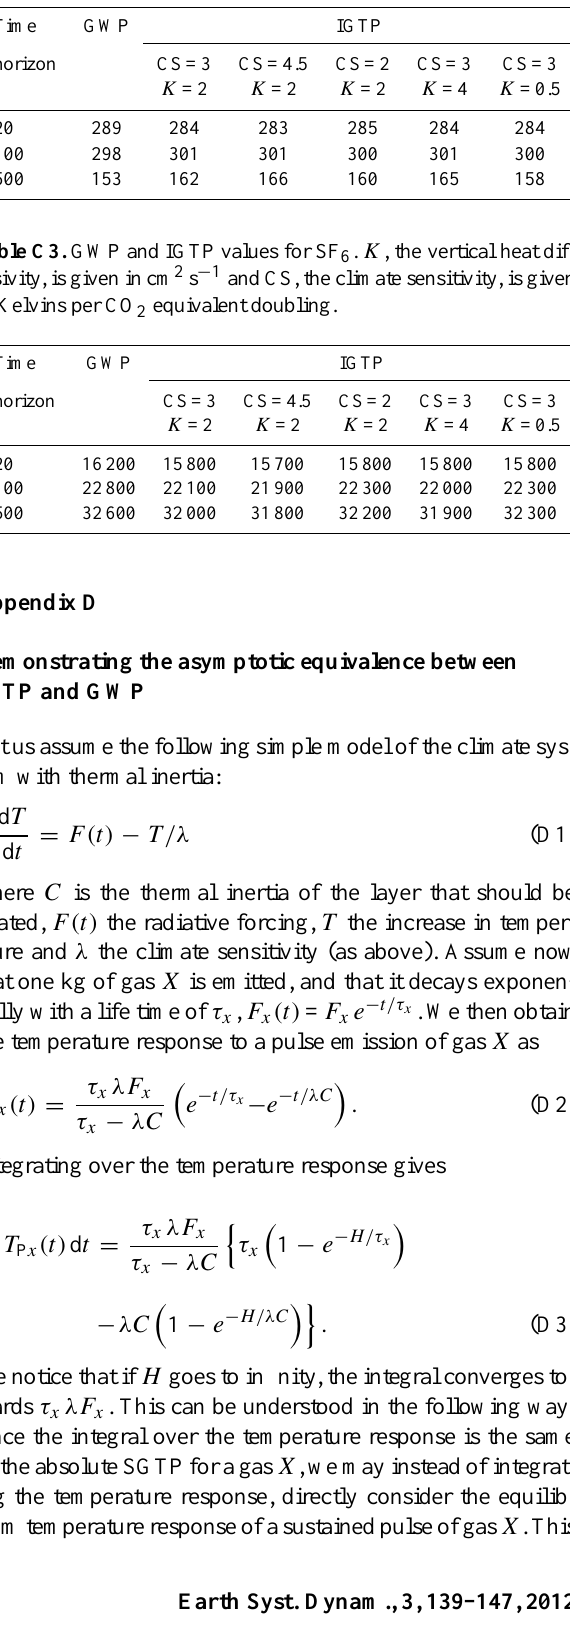
Table C2. GWP and IGTP values for N 2 O. K , the vertical heat diffusivity, is given in cm 2 s − 1 and CS, the climate sensitivity, is given in Kelvins per CO 2 equivalent doubling.